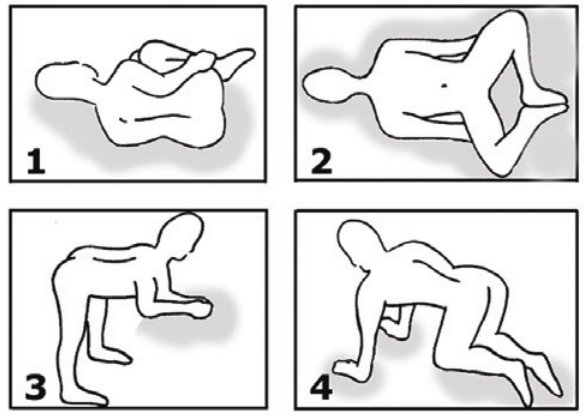
Figure 1 - The Burdizzo clamp (A) positioned to crush the spermatic cord (B).